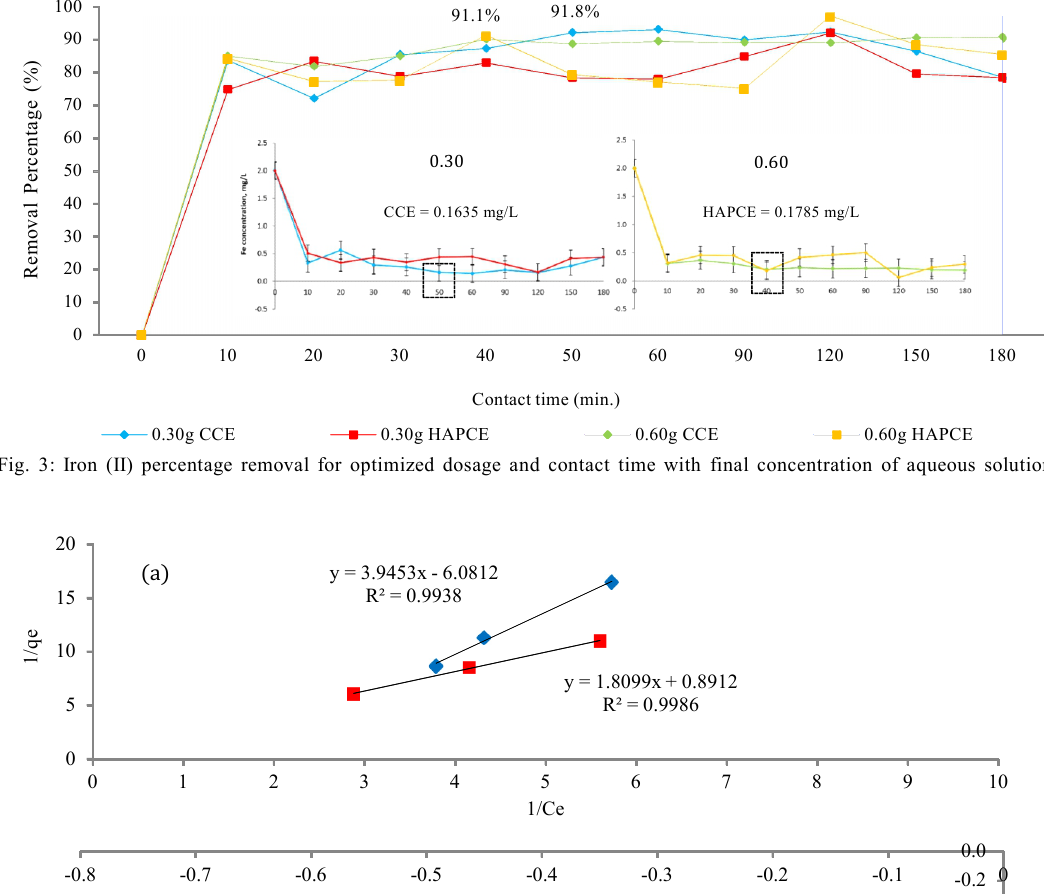
y = 1.8099x + 0.8912 R² = 0.9986